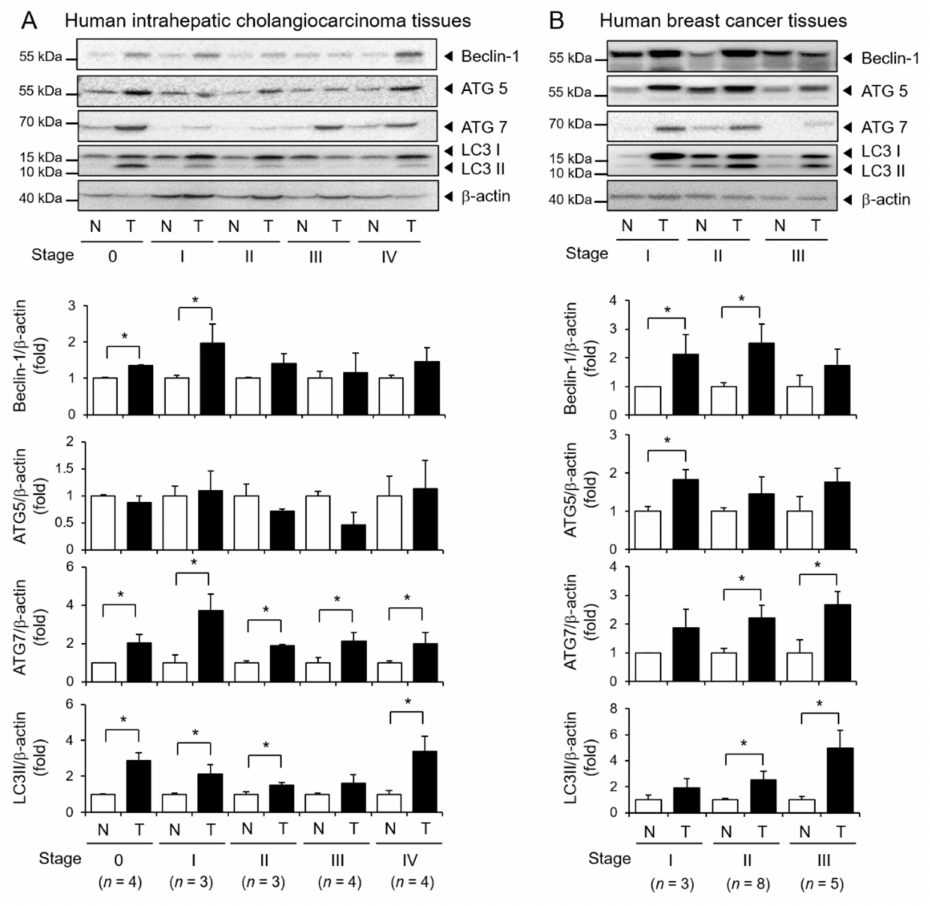
Figure 7. The expression of autophagy markers in patient-derived tumor tissues and nontumor tissues. ( A ) Five pairs of human intrahepatic cholangiocarcinoma tissues in different stages and nontumor tissues were analyzed for autophagy marker expression by immunoblotting. ( B ) Three pairs of human breast tumor tissues in different stages and nontumor tissues were analyzed for autophagy marker expression by immunoblotting. β -actin was used as the loading control. For A and B, density was measured and expressed as bar graphs. Values represent means ± SEM ( n = 3). * p <